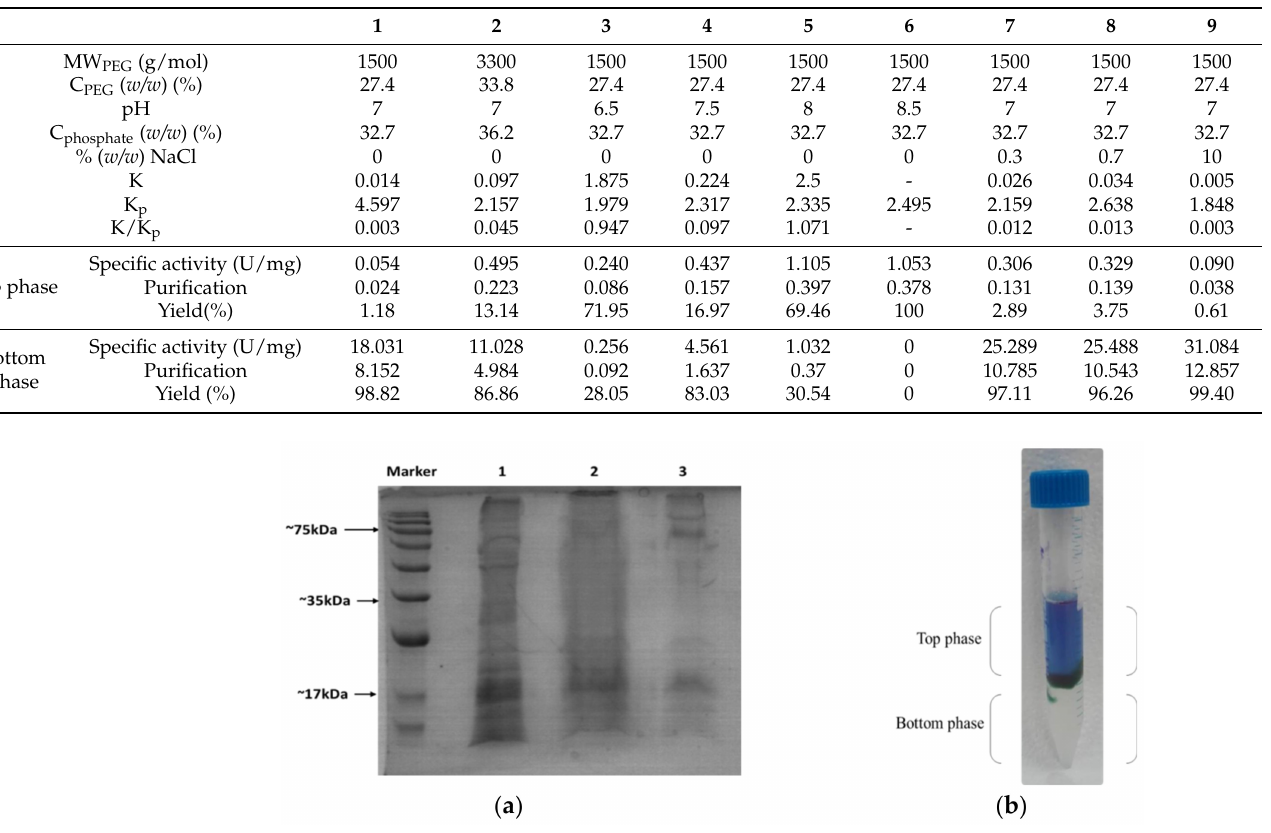
Figure 5. ( a ) SDS-PAGE of A. platensis lysate (1:50 µ g of protein), bottom phase of ATPS (2:50 µ g of protein) and bottom phase of ATPS after dialysis (3:12.5 µ g of protein). ( b ) Top and bottom phases of ATPS (27.4% ( w / w ) PEG1, 500, 32.7% ( w / w ) phosphate pH 7 with a concentration of 10% ( w / v ) NaCl, 30% ( w / w ) ddH2O, 10% ( w / w ) A. platensis lysate (protein concentration 1.7 mg/mL)). The bottom phase of the ATPS was evaluated by SDS-PAGE, and the molecular masses of the proteins are shown in Figure 5a. A main protein zone between 63 and 75 kDa and some other minor zones were clearly visible (Figure 5a, lane 3). Zymography of a bottom- phase sample allowed the identification of two protein zones with high proteolytic